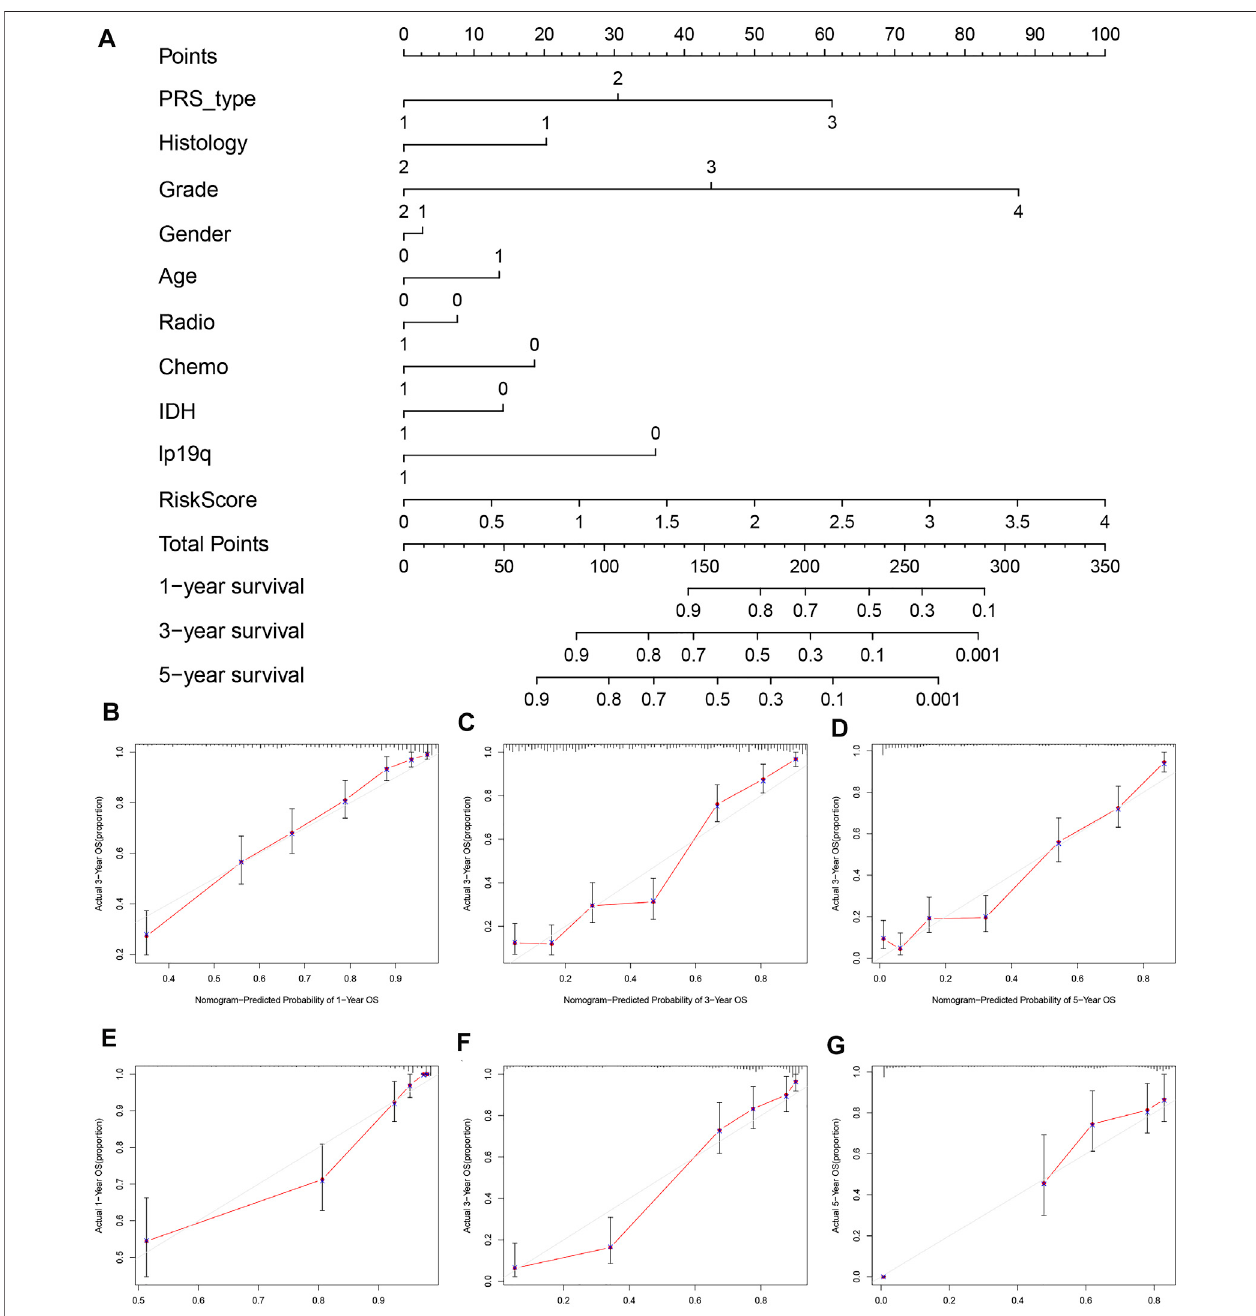
FIGURE 5 | Establishment and validation of nomogram model based on prognostic signature genes. (A) Nomogram model established in the CGGA cohort. (B) The1-yearcalibrationcurvesintheCGGAcohort. (C) The3-yearscalibrationcurvesintheCGGAcohort. (D) The5-yearscalibrationcurvesintheCGGAcohort. (E) The 1-year calibration curves in the TCGA cohort. (F) The 3-years calibration curves in the TCGA cohort. (G) The 5-years calibration curves in the TCGA cohort.